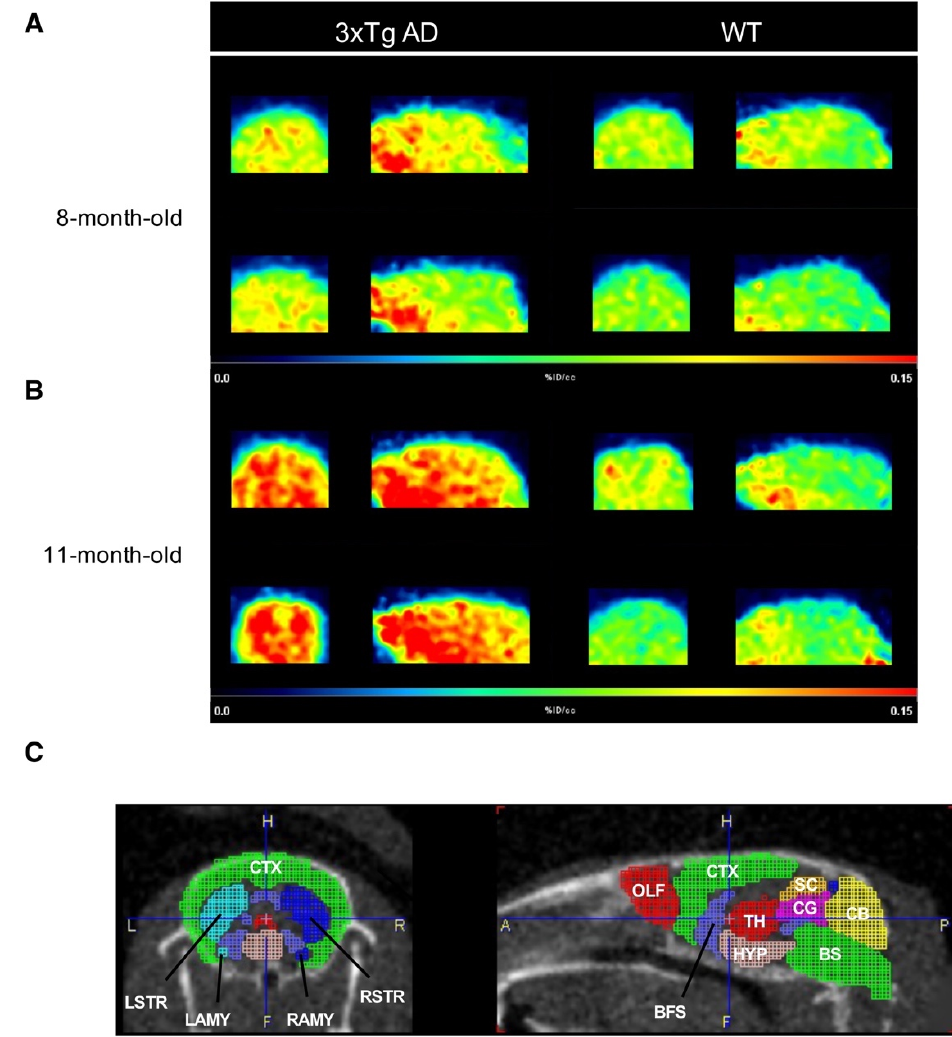
Figure 4. In vivo epigenetic imaging of using [ 18 F]TFAHA. Representative [ 18 F]TFAHA PET imaging of 3xTg AD mice and WT mice at ( A ) 8 and ( B ) 11 months of age. Coronal (left) and sagittal (right) slices were projected on a built-in T1 MRI mouse template of Pmod software (scale by %ID/c.c). ( C ) Schematic illustration of a mouse coronal and sagittal brain section depicting several regions of interest (ROI) used for the quantification of PET imaging. Abbreviation: CTX, cortex; STR, striatum; TH, thalamus; BFS, basal forebrain; AMY, amygdala; CB, cerebellum; OLF, olfactory bulb; CG, cingulate cortex; BS, pons plus